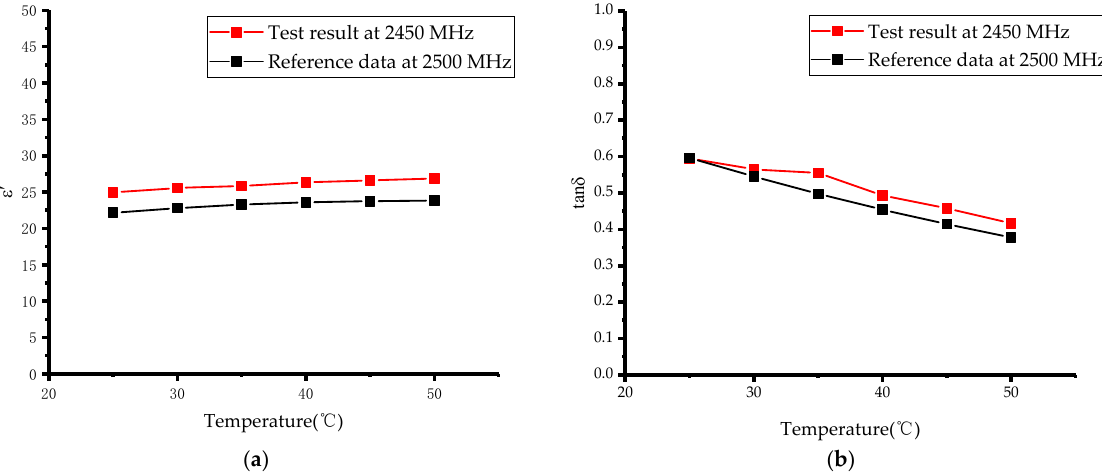
(cid:4593) ; ( b ) tan δ .